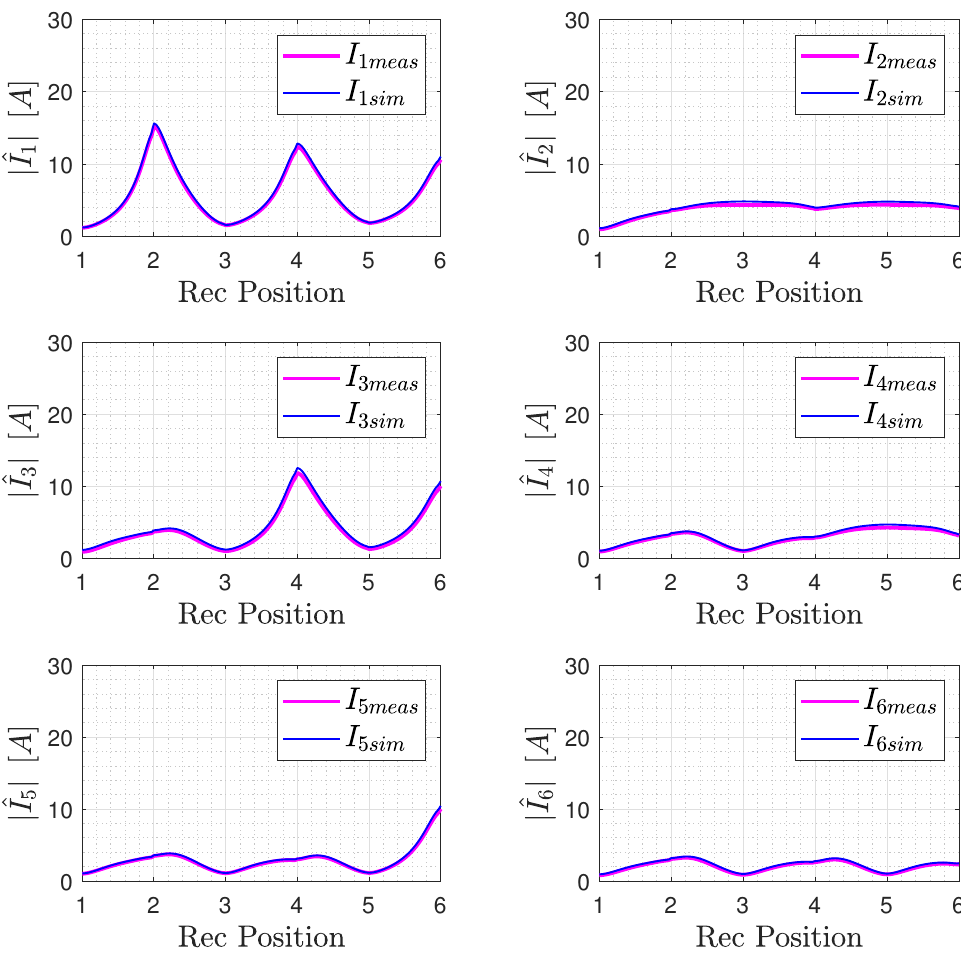
Figure 21. Comparison between the numerical and experimental values of the resonator current magnitude for different receiver positions in the case of ˆ Z T = 1.5 Ω and ˆ Z load = 5 Ω